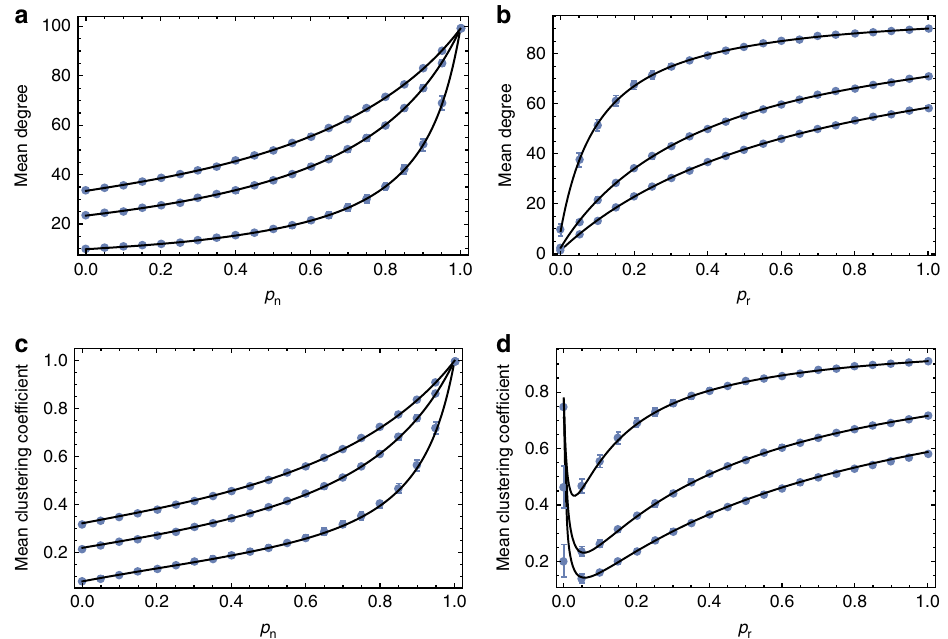
Figure 2 | Mean degree and clustering coefficient as a function of model parameters. The dependency of mean degree ( a , b ) and clustering coefficient ( c , d ) on social inheritance, p n ( a , c ), and probability of random bonding, p r ( b , d ). In each panel, the black curves depict our analytical approximation while the blue dots with error bars are mean and s.d. of 50 replicate runs. For the two panels on the left, the curves correspond to, from top to bottom, p r ¼ 0.5, 0.3 and 0.1; for the two panels on the right, from top to bottom, p n ¼ 0.9, 0.6 and 0.3. For all panels, network size N ¼ 100; the simulations were initiated with random networks and run for 2,000 time steps. NATURE COMMUNICATIONS|7:12084|DOI: